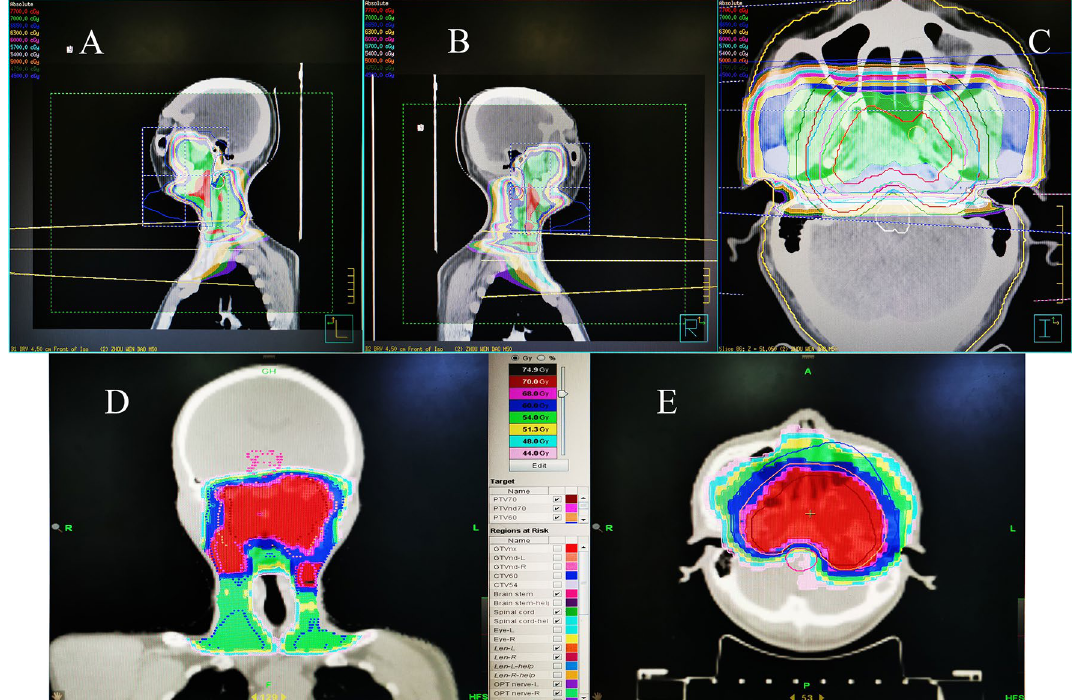
Figure 1. The dose distribution diagram of neck and nasopharyngeal for 3D-CRT ( A – C ) and IMRT ( D , E